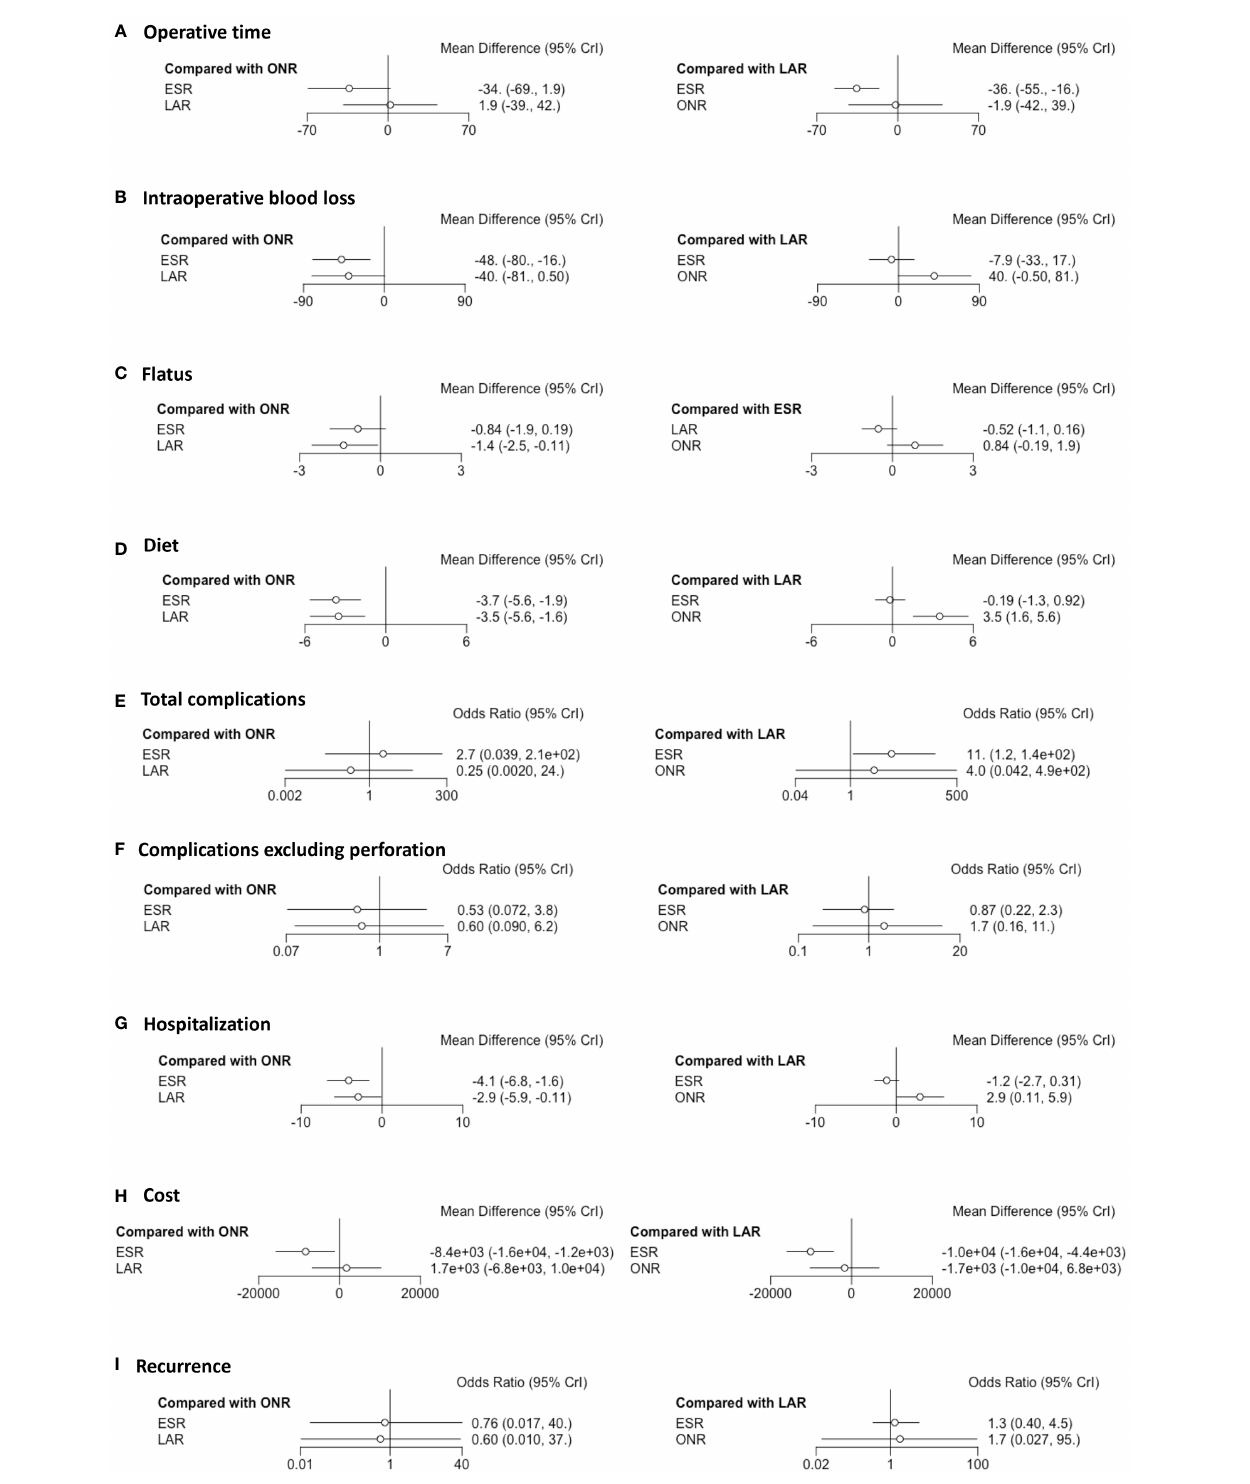
FIGURE 2 | Forest plots of the network meta-analysis between endoscopic resection, laparoscopic resection, and open resection. The (A) operative time, (B) intraoperative blood loss, (C) fl atus, (D) diet, (E) total complications, (F) complications excluding perforation, (G) hospitalization, (H) cost and (I) recurrence were analyzed